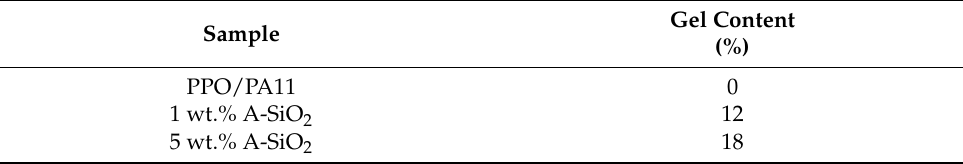
Table 1. Rheological data of PPO, PA11, and PPO/PA11/silica